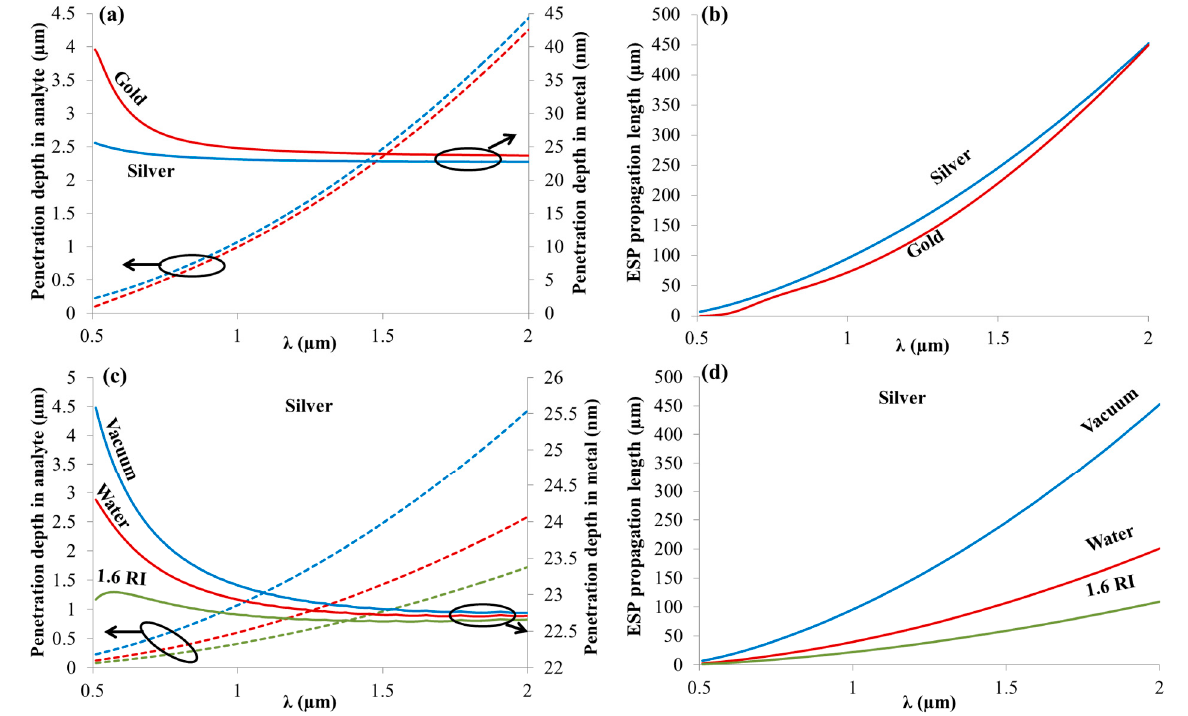
Figure 2. ( a ) Penetration depths of an ESP wave in vacuum (dashed curves) and in metal (solid curves) for silver (blue) and gold (red); ( b ) ESP propagation lengths along silver/vacuum (blue) and gold/vacuum (red) interfaces; ( c ) penetration depths of an ESP wave in metal (solid curves) for silver and for different types of analyte mediums: Vacuum (blue), water (red), and 1.6 RI close to organic material (green); ( d ) ESP propagation lengths along silver/analyte interface for different types of analytes: Vacuum (blue), water (red), and (1.6 RI). The dispersion of water was considered in the calculations.